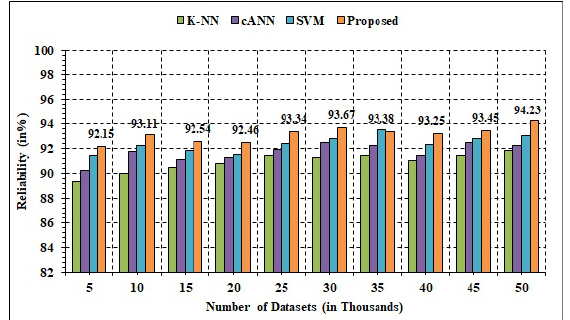
Figure 7. Reliability